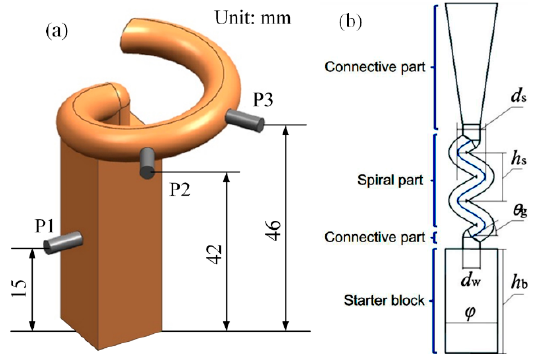
Figure 1. Temperature measurement experiment: ( a ) arrangement of measuring points and ( b ) structure of typical spiral selector.